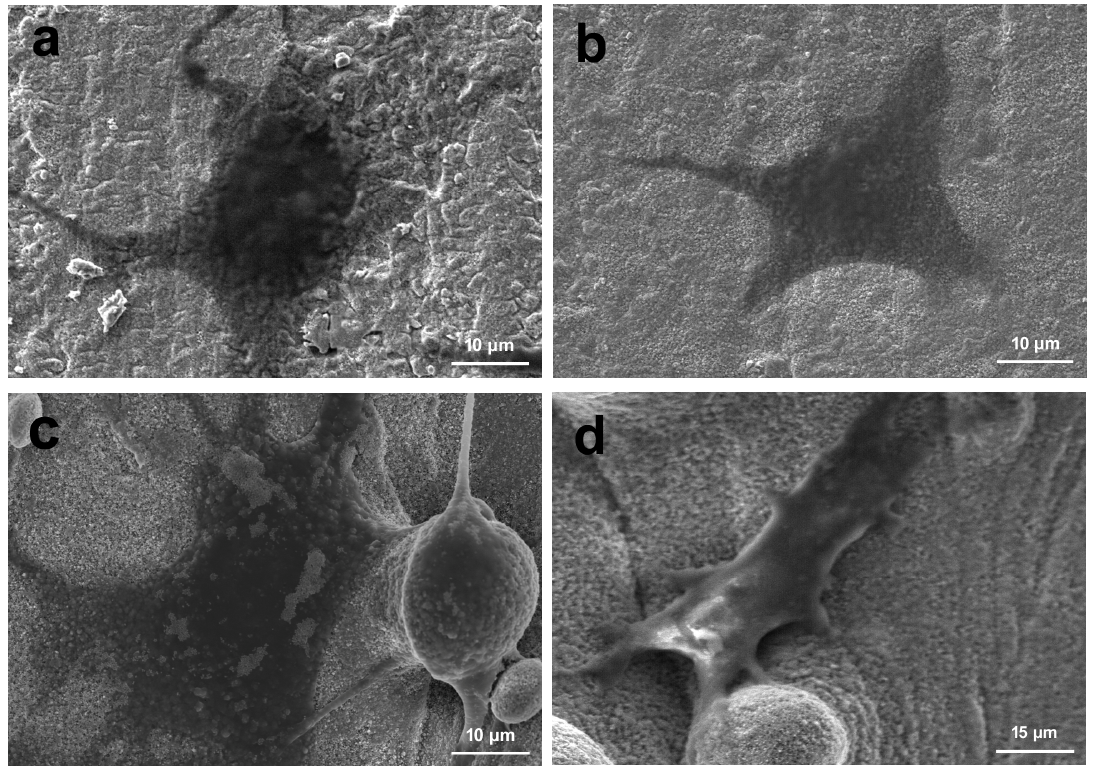
Figure 8. SEM images of MC3T3-E1s cell cultured on the ( a , b ) MBG-SLM-Ti and ( c , d ) MBG-CP-Ti after 3 day.